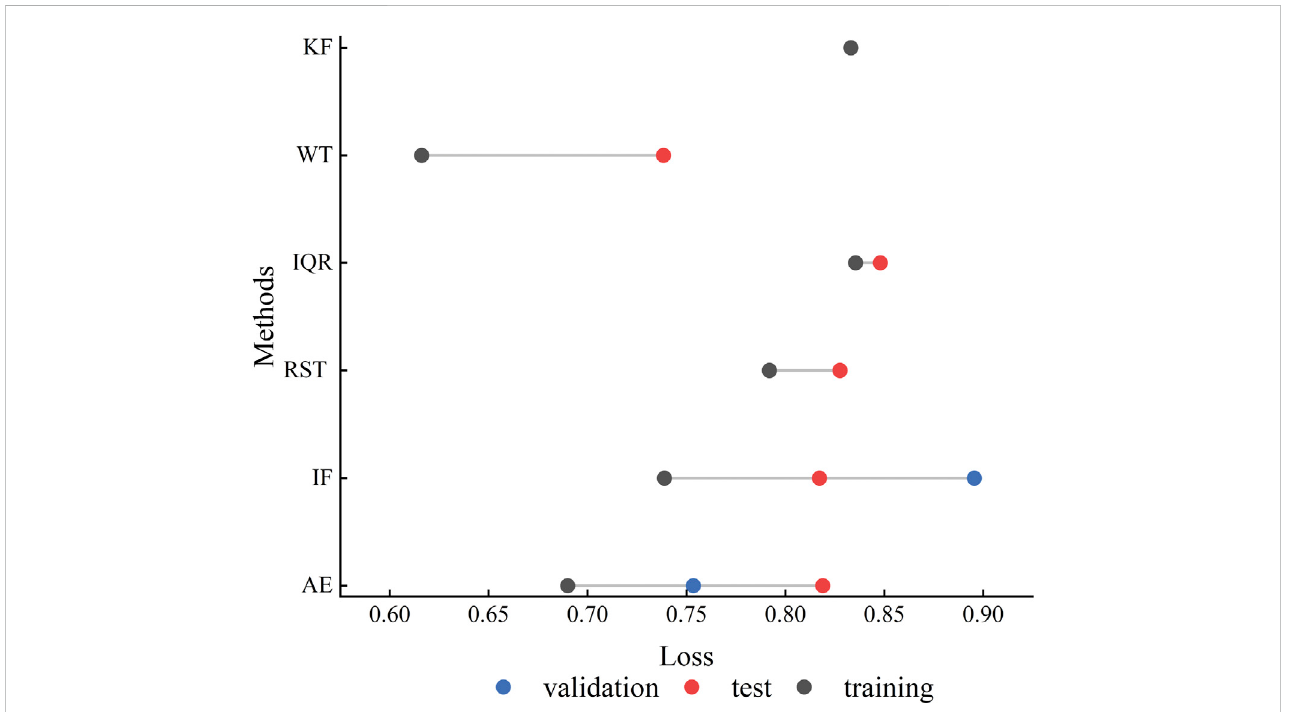
FIGURE 7 The result of the Loss values for six methods. (AE,IF,RST,IQR,WT,KF). The x -axis is the Loss value and the y -axis represents the different methods. Three colors correspond to the training-test-validation steps (red is the training phase, blue is the test phase and black is the validation phase).